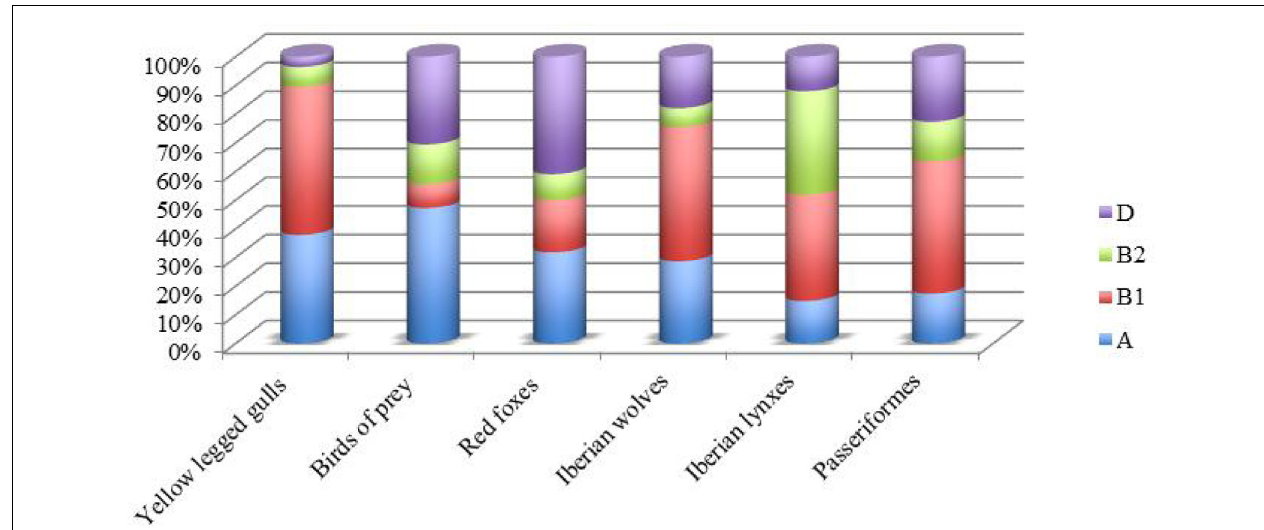
FIGURE 1 | Phylogenetic group distributions of E. coli in wild animal from Portugal.